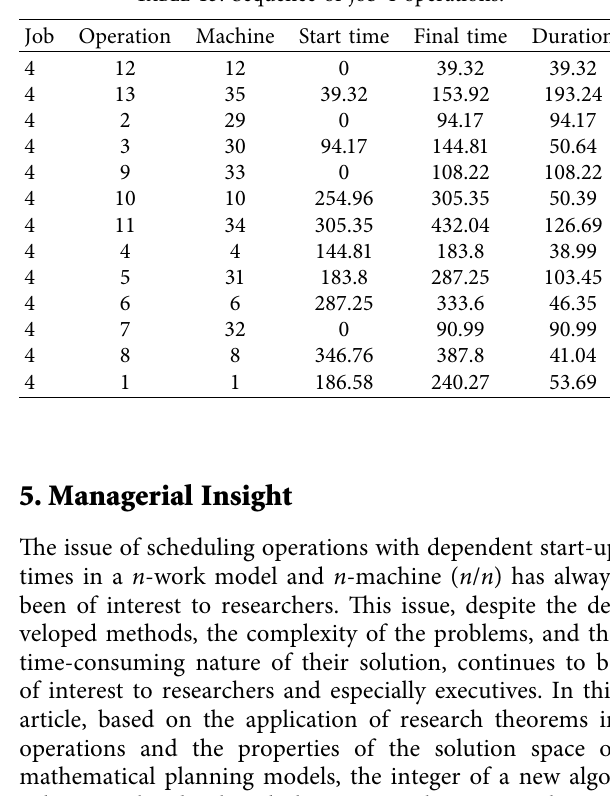
Table 15: Sequence of job 4 operations.